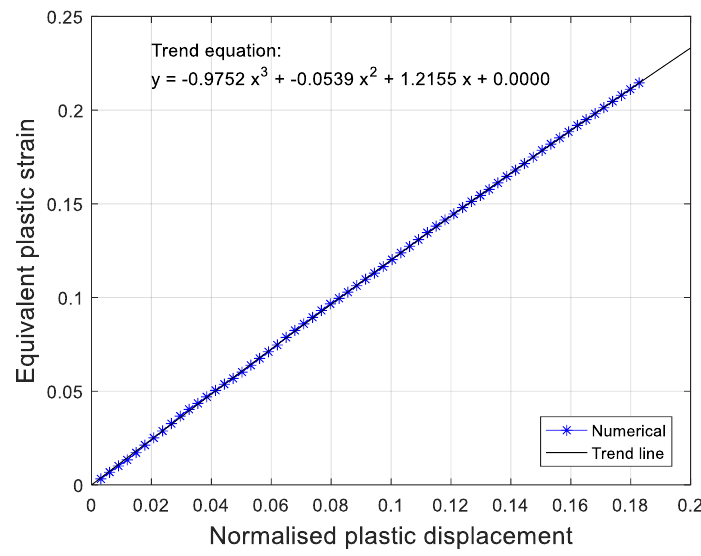
Figure A3. Evolution of ε eq as a function of the normalised plastic displacement.